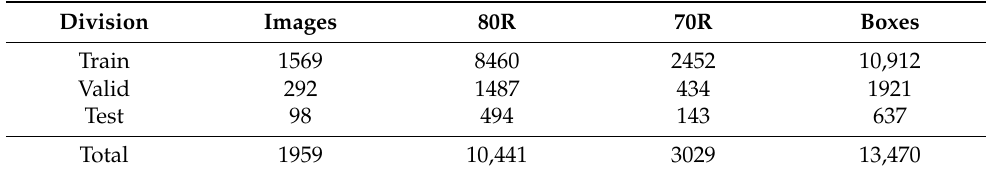
Figure 1. The conditions of images in the dataset under ( a ) similar background; ( b ) clusters; ( c ) occlusion; ( d ) front light; ( e ) dense target. Table 2. Annotation count (A C )